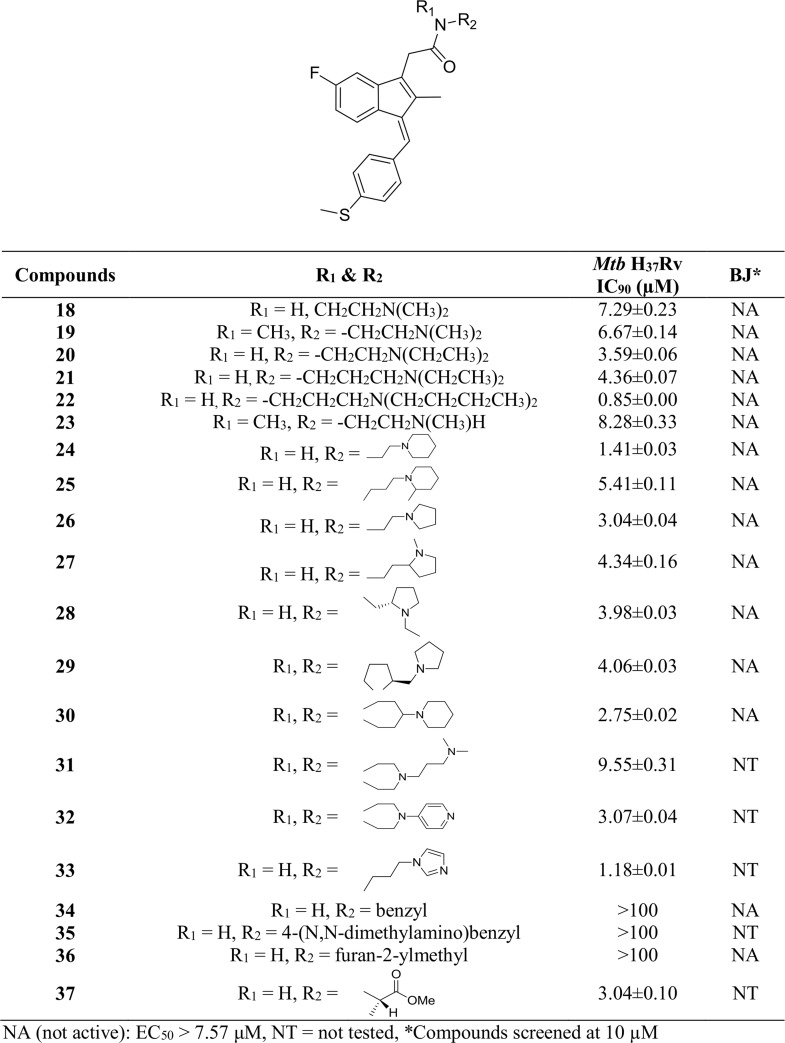
Mtb H37Rv and BJ cell data of Sulindac sulfide amide derivatives 18–37.